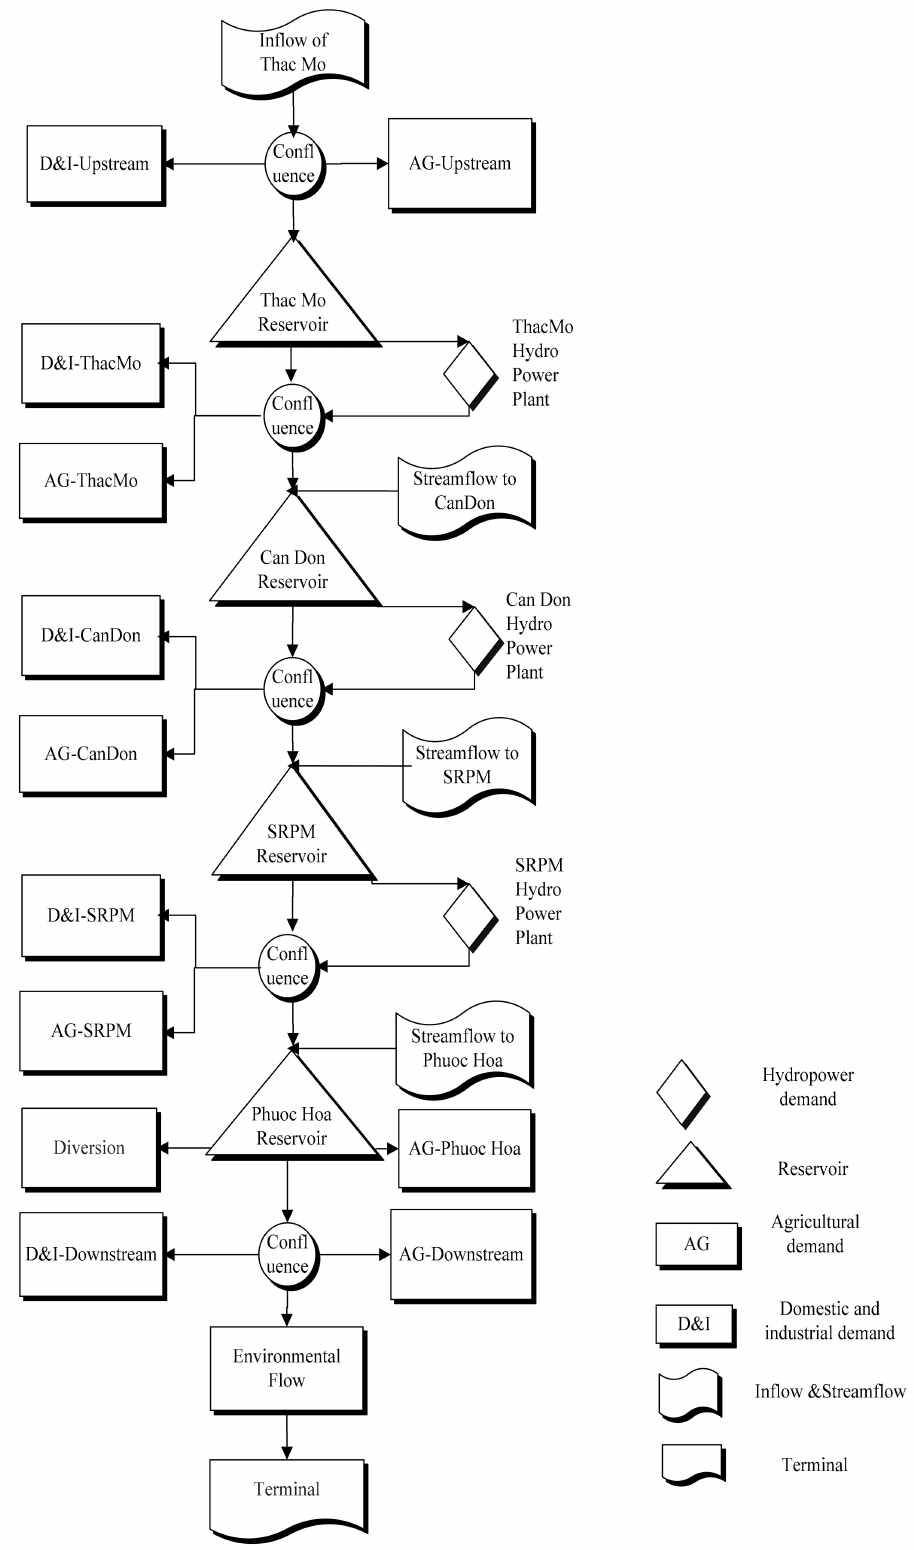
Figure 2. A node-arc representation of the Be River water resources